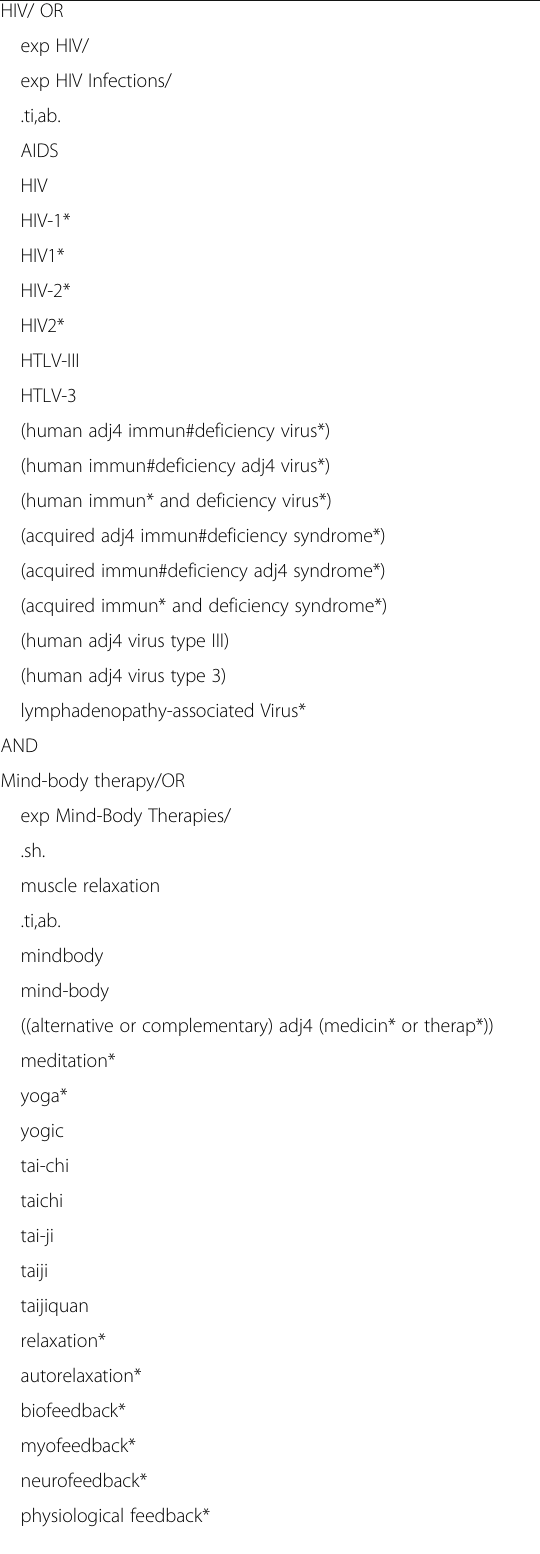
Table 1 Ovid MEDLINE®, In-Process & Other Non-Indexed Citations and OvidMEDLINE(R) 1946 to Present, search strategy